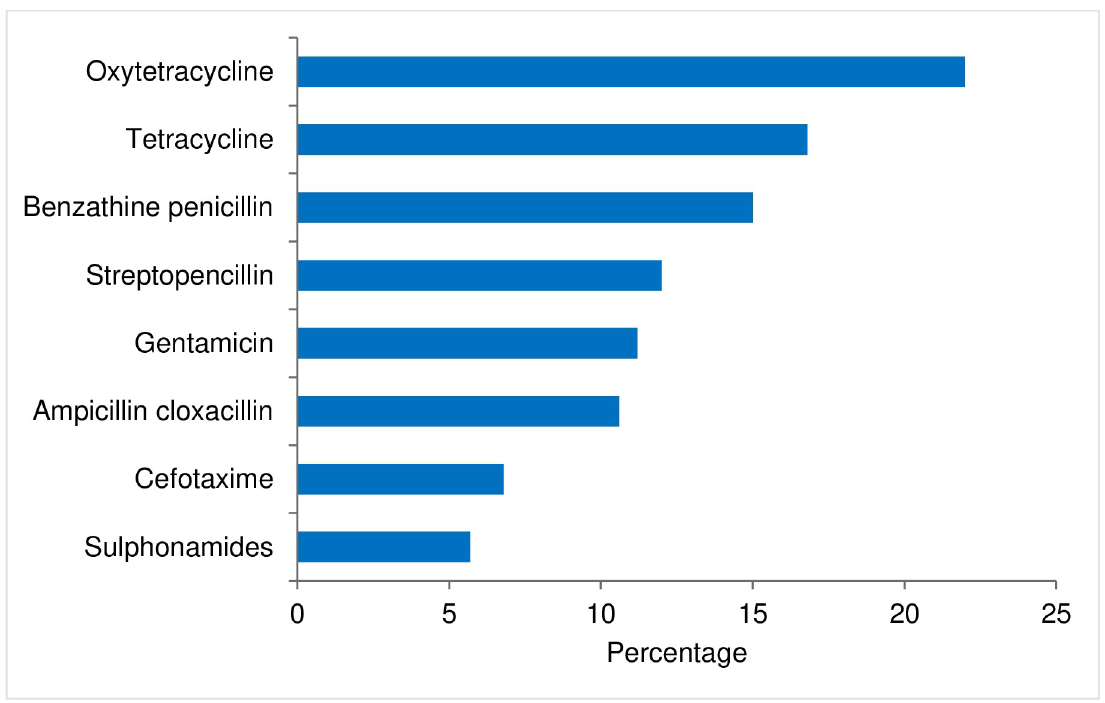
Fig 4. Most used antibiotics in Bhutan based on the information provided by the 219 animal health workers (respondents).